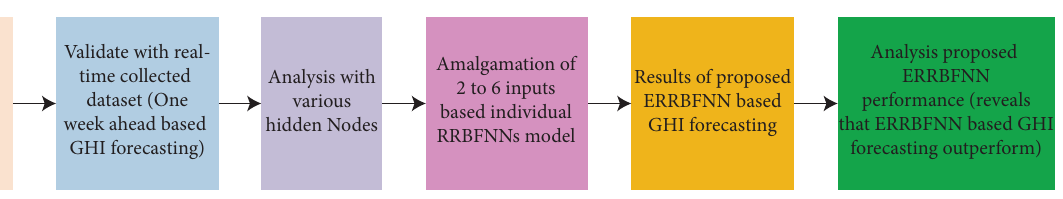
Figure 1: Graphical overview.